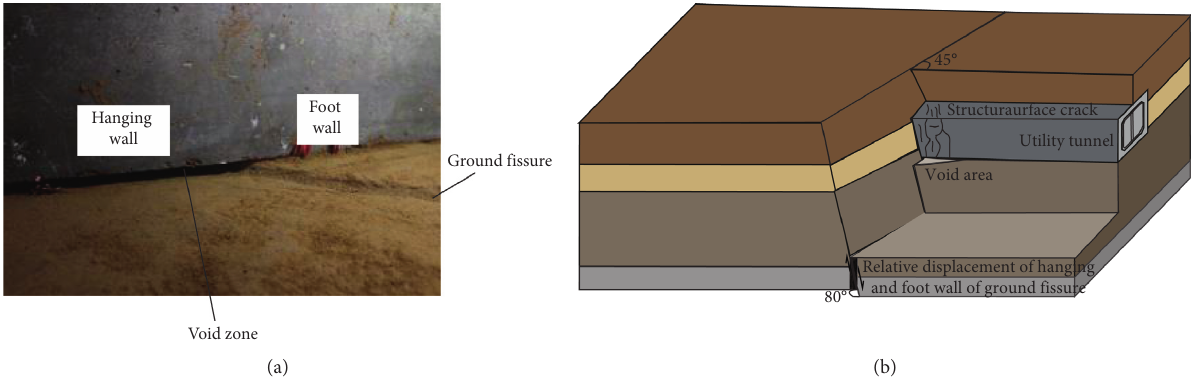
Figure 8: Physical model test of the ground fissure section utility tunnel void zone. (a) Model test void zone. (b) Model test void